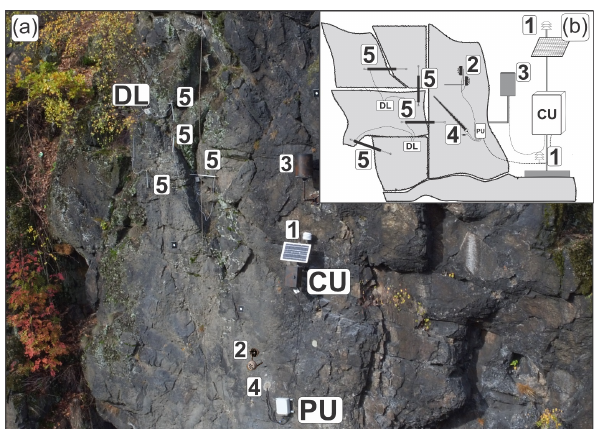
Figure 1. Photo of the monitoring system at the Tašovice site: (a) generalised scheme of the monitoring system (b) CU: control unit, PU: processing unit, DL: datalogger, 1: temperature sensor, 2: pyra- nometers, 3: rain gauge, 4: borehole compound temperature probe, 5: crackmeters (only four of a total of six crackmeters are visible on this photo).